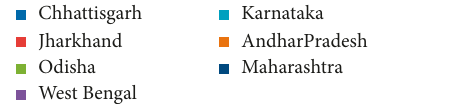
Figure 1: Production of GBFS in FY 2018-19 of India [17, 18]. Table 1: Model details used in the study performance